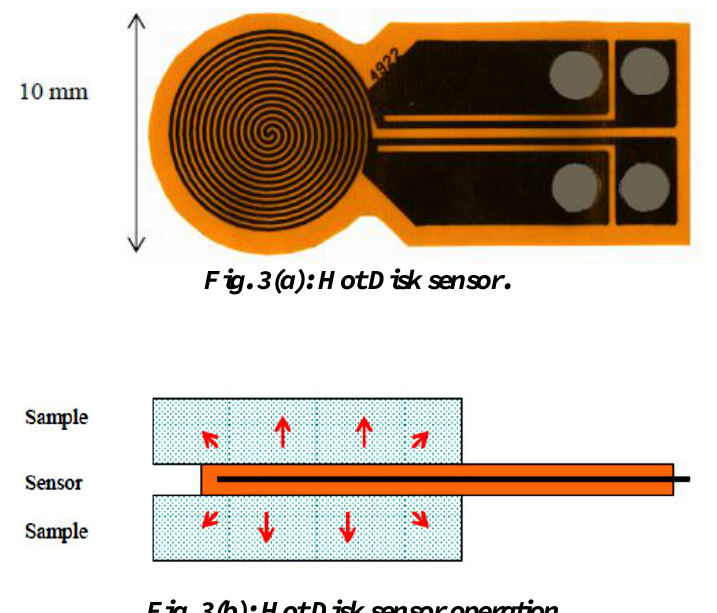
Fig. 3(b): Hot Disk sensor